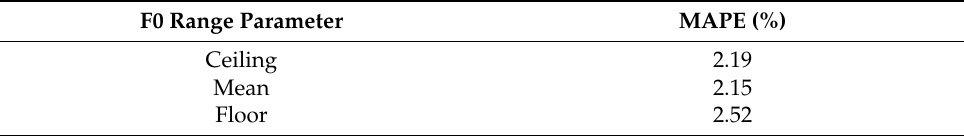
Table 1. MAPE for F0 range estimation with the refined